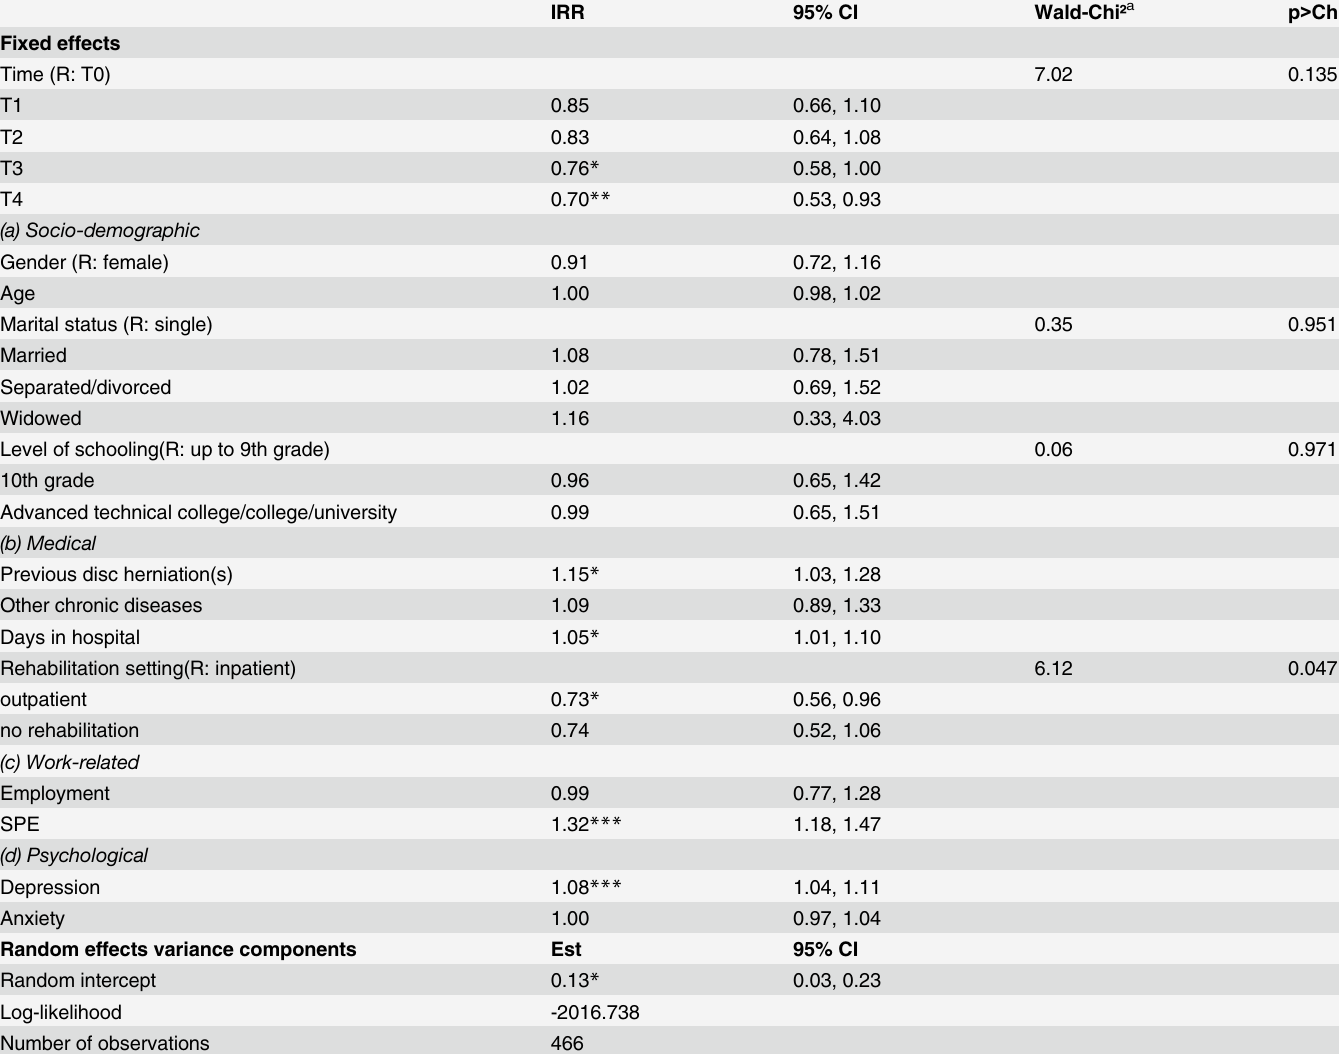
Table 3. Predictors for postoperative pain in patients with cervical disc herniation (n = 112). IRR 95% CI Wald-Chi² a p >